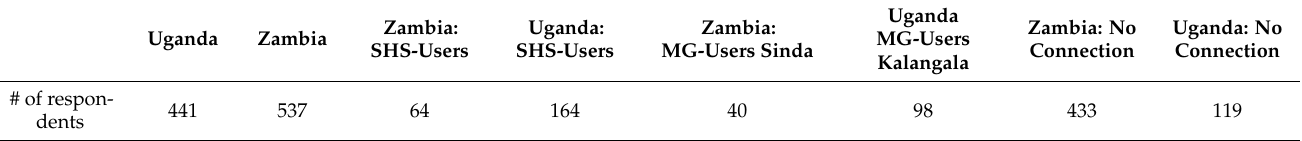
Table 2. Community Surveys Uganda and Zambia—number and groups of respondents. Zambia: Uganda: SHS-Users